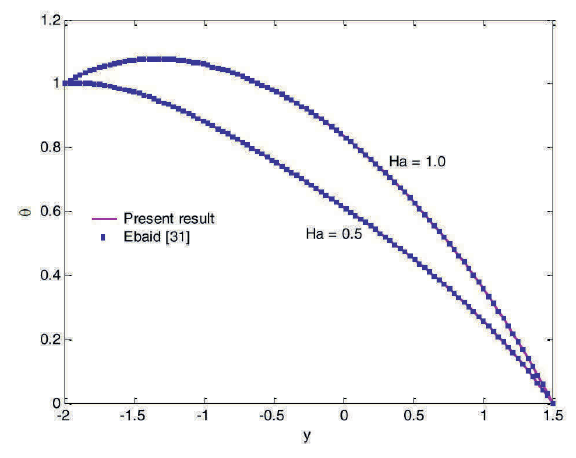
Fig. 3: Comparison of temperature distribution for two distinct val- ues of Ha